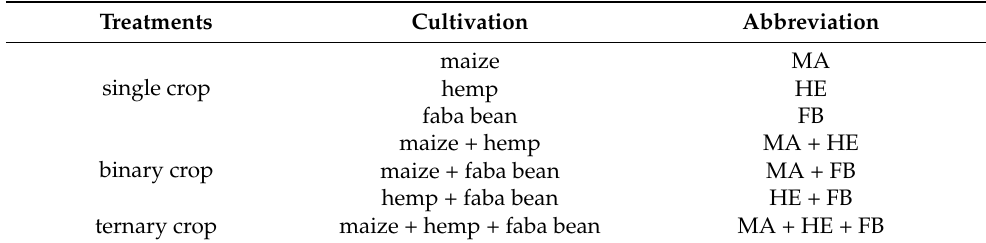
Table 2. Crop bio-diversity